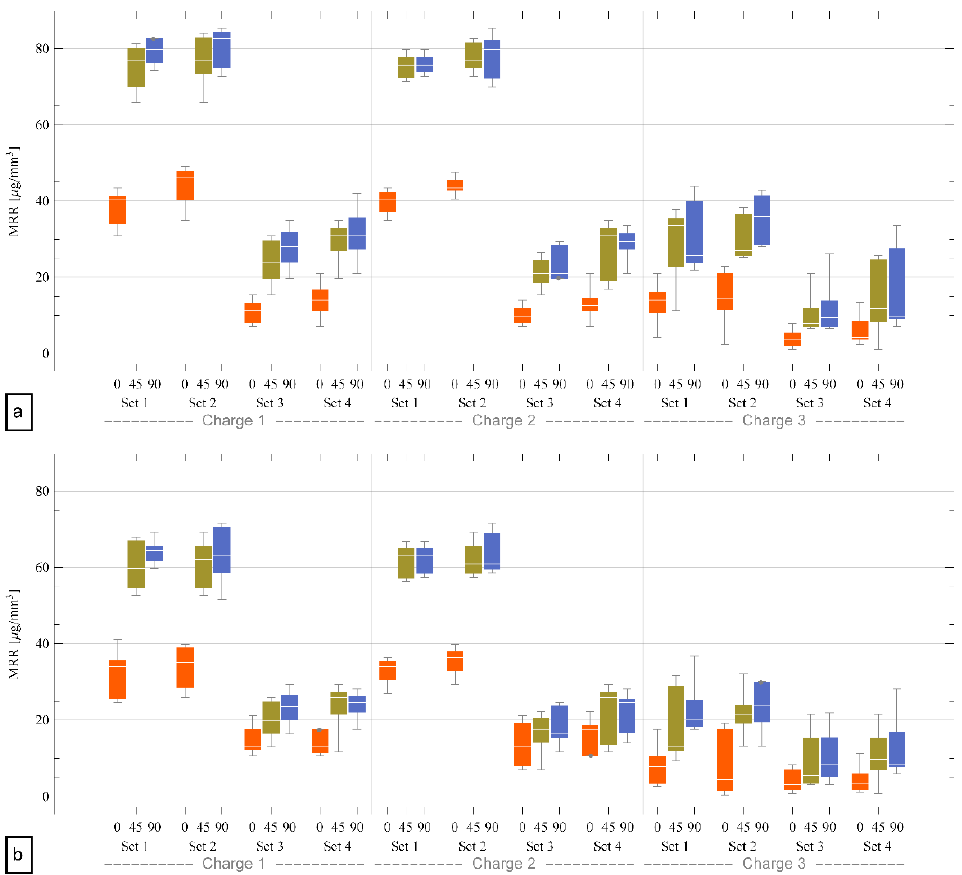
Figure 11. Box-and-whiskers charts of the material removal rate (MRR) for different surface inclinations (0°, 45°, 90°), using different BF process parameter sets (1, 2, 3, 4) and charge types (1, 2, 3), for Ti6AL4V ( a ) and Inconel718 ( b ).